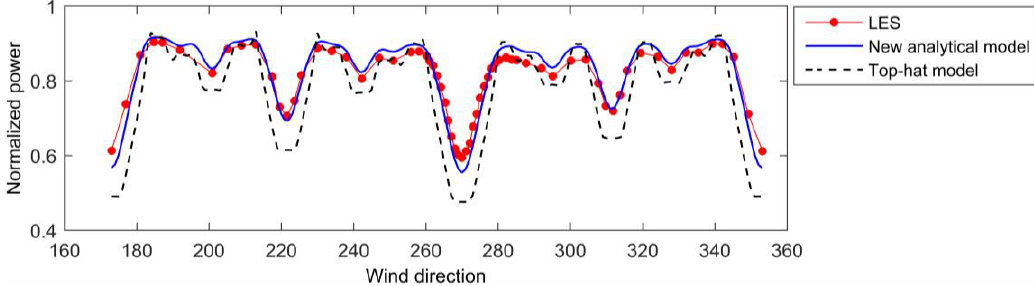
Figure 5. Distribution of the normalized Horns Rev wind farm power output obtained with the new analytical model and LES for different wind directions.